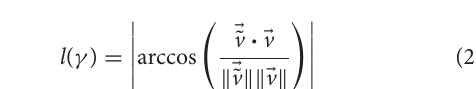
spatial velocity such that: TABLE 2 | Adaptive form of tree Parzen estimator (ATPE) tuning network